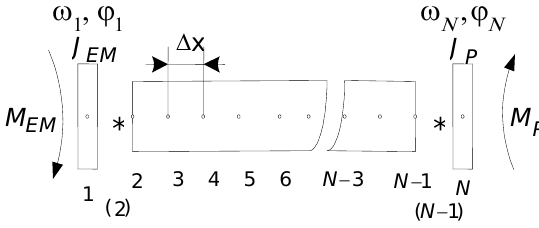
Figure 3. Calculation scheme of the shaft continuum. Figure 3 includes the following symbols: J EM —moment of inertia of the motor’s drive rotor, J P —moment of inertia of the hydraulic pump rotor recalculated considering the reducer gear, y, ω 1 , ϕ 1 —angular velocity and rotation angle of the drive motor rotor, ω N , ϕ N —angular velocity and rotation angle of the vertical pump rotor, x — discretisation step of the long shaft equation, * — fictitious discretization node, and N — number of dis- cretisation nodes.